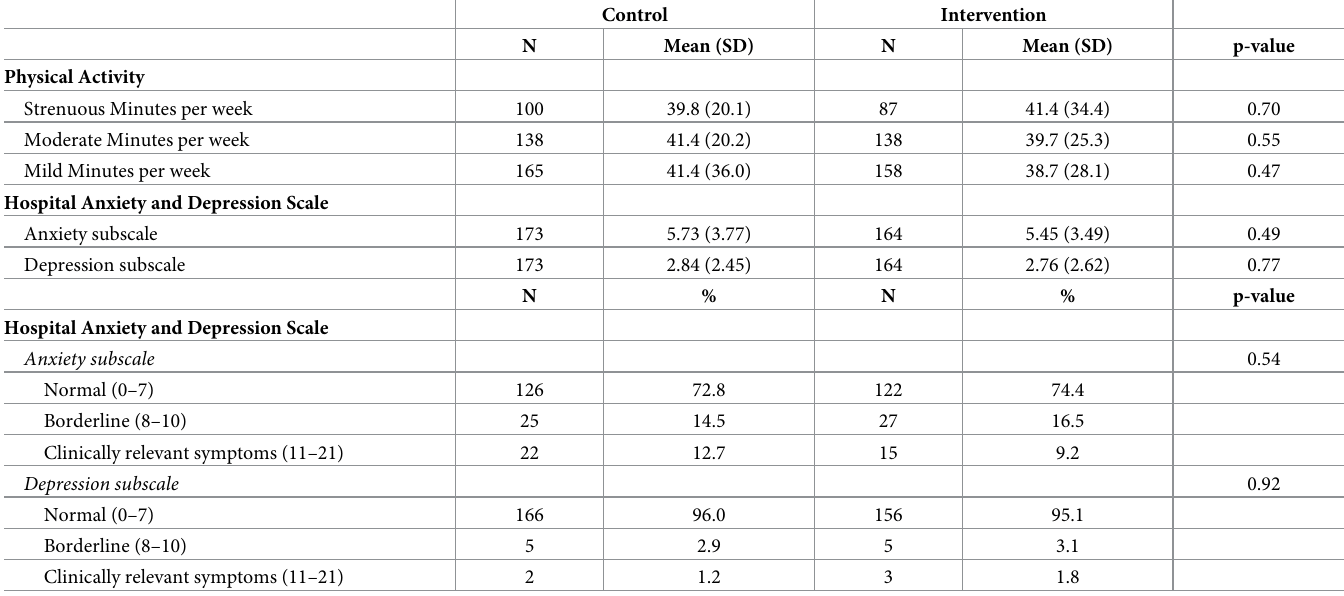
Table 7. Potential unintended consequences—physical activity, depression, and anxiety—at week 12 by intervention